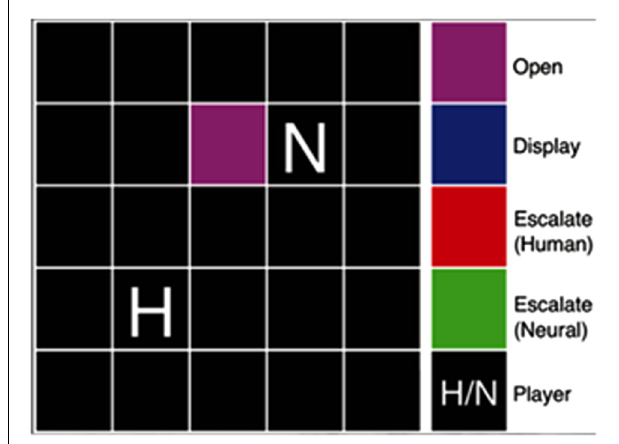
FIGURE 3 | Hawk-Dove game diagram. The game board included a 5 × 5 grid of squares, upon which a territory was marked and the human and neural agent players were placed.The color of the territory reflected the state of the players’ actions. In the Hawk-Dove, two players must compete for a territory, deciding either to be submissive (display) or aggressive (escalate), avoiding or risking injury in hopes of a larger payoff, respectively. © 2012 IEEE. Reprinted, with permission, from Asher etal.